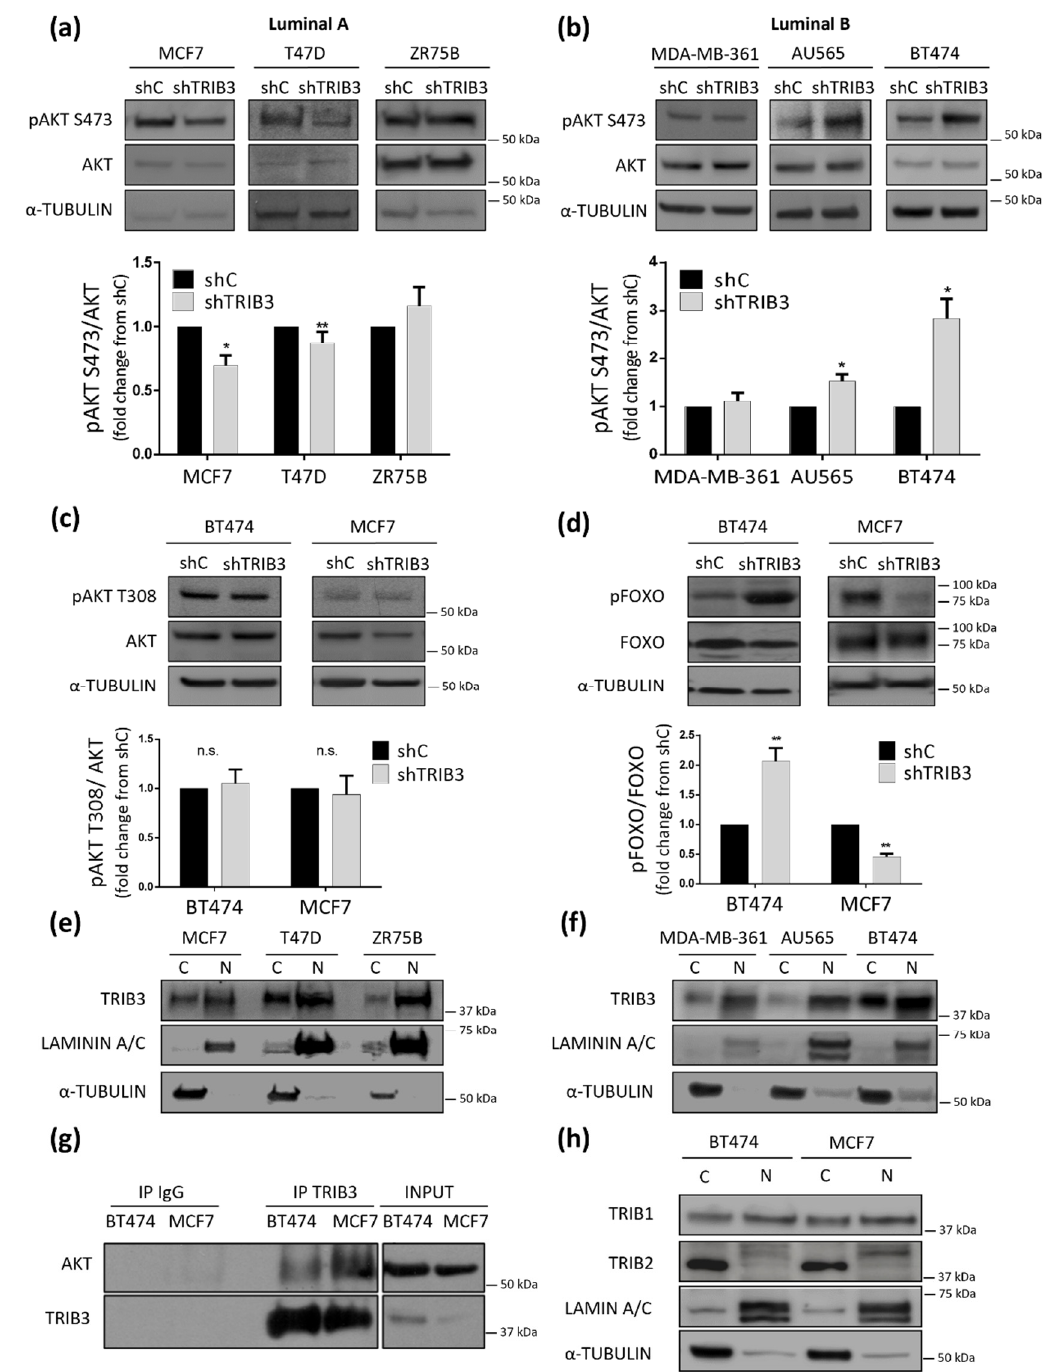
Figure 2. TRIB3 regulates differently the AKT pathway in luminal A and luminal B breast cancer cell lines. ( a , b ) The effect of TRIB3 silencing on AKT phosphorylation at serine 473 of luminal A ( a ) and luminal B ( b ) breast cancer cell lines. Upper panel: The Western blot images of a representative experiment are shown. Lower panel: The densitometric analysis of AKT phosphorylation at serine 473 (pAKT S473). The data correspond to the optical density values in arbitrary units for each experimental condition normalized with respect to the total AKT and B-ACTIN levels and are expressed as the mean fold change ± SEM with respect to shC for each case ( n = 6–12; * p < 0.05, ** p < 0.01 with respect to shC; Wilcoxon test). ( c ) The effect of TRIB3 silencing on AKT phosphorylation at threonine 308 in BT474 (luminal B) and MCF7 (luminal A) breast cancer cell lines. Upper panel: The Western blot images of representative experiments are shown. Lower panel: The den- sitometric analysis of AKT phosphorylation at threonine 308 (pAKT T308). The data correspond to the optical density values in arbitrary units for each experimental condition normalized with respect to the total AKT and B-ACTIN levels and are expressed as the mean fold change ± SEM with respect to the corresponding shC condition ( n = 6). ( d ) The effect of TRIB3 silencing on FOXO1/3 phosphorylation (FOXO1 at threonine 24 and FOXO3 at threonine 32; pFOXO1